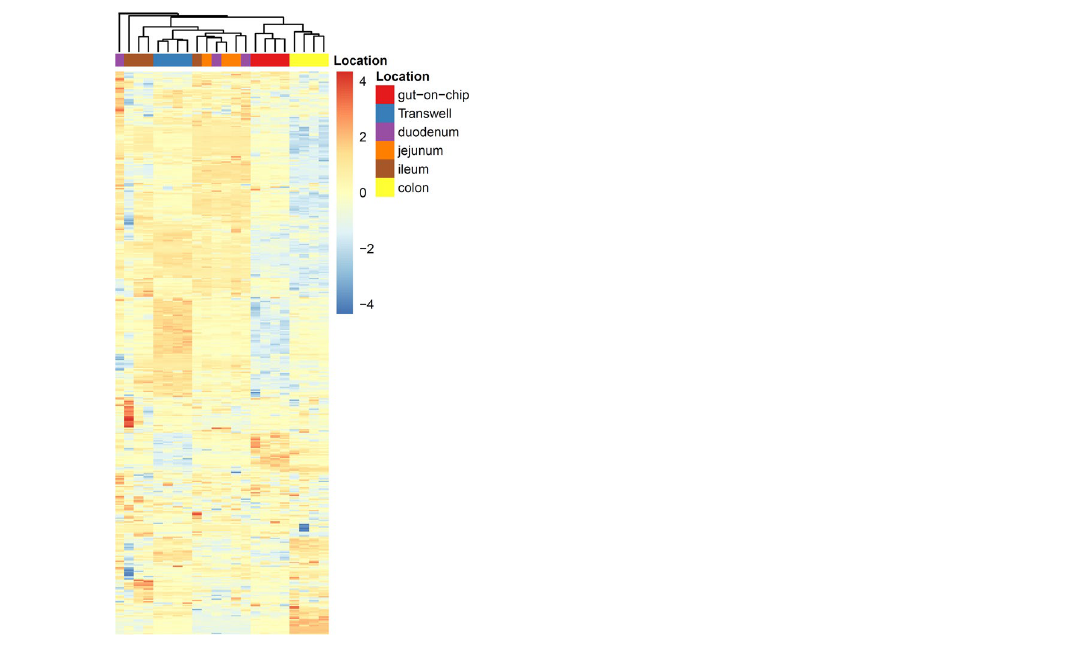
Figure 6. Hierarchical clustering of the expression data of 483 of human intestine-specific genes in Caco-2 cells grown in the gut-on-chip or Transwell and in human intestinal tissue samples. Heatmaps of selected genes were made using the R library pheatmap (version 3.6.3, https ://cran.r-proje ct.org/web/packa ges/Pheat map/index .html) 23